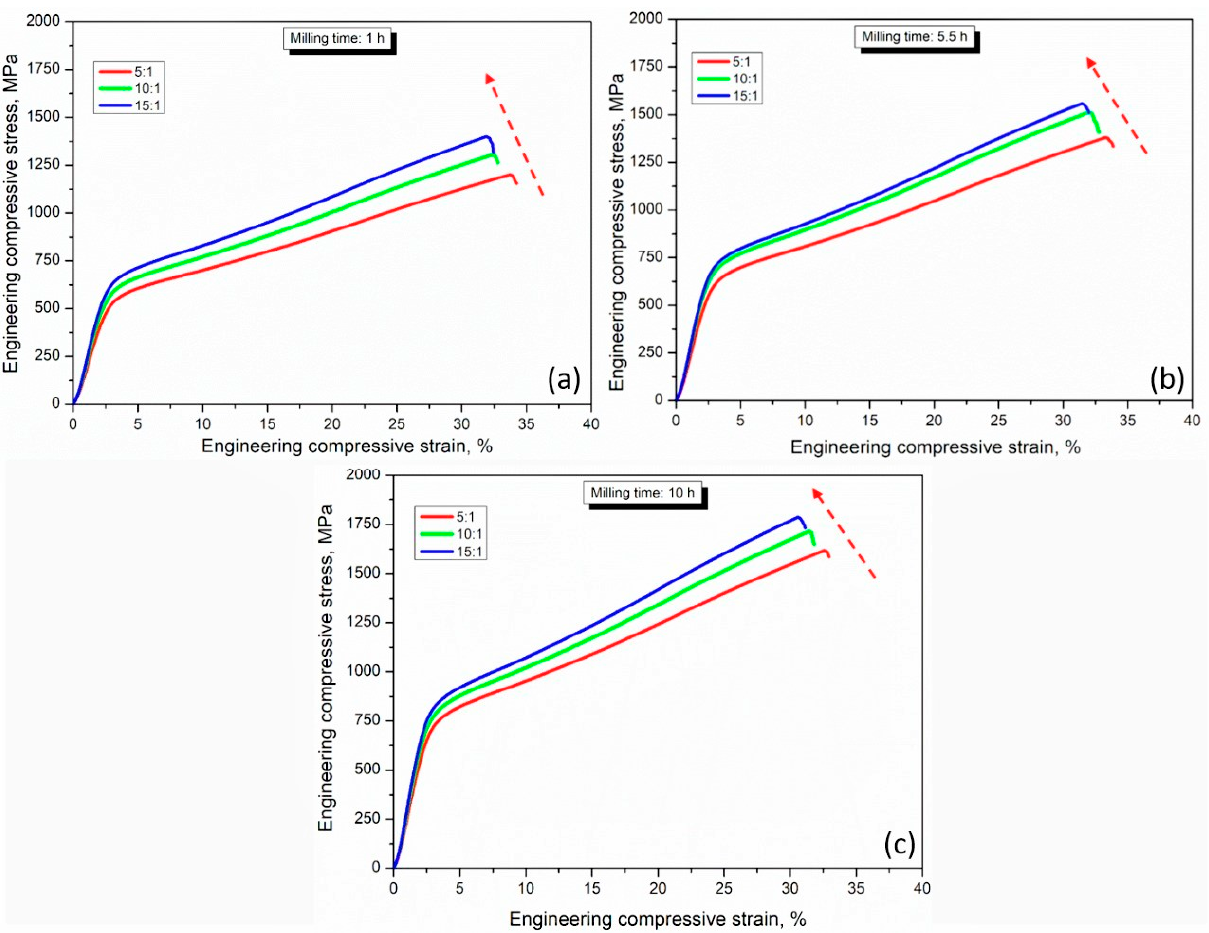
Figure 11. Engineering compressive stress–strain curves of FeMn 30 Cu 5 hot-forged biodegradable alloys processed under different milling conditions: ( a ) 1 h and BPRs (5:1, 10:1, and 15:1); ( b ) 5.5 h and BPRs (5:1, 10:1, and 15:1); ( c ) 10 h and BPRs (5:1, 10:1, and 15:1). The arrow indicates the significance of mechanical milling parameters on compressive stress–strain performance upwards.